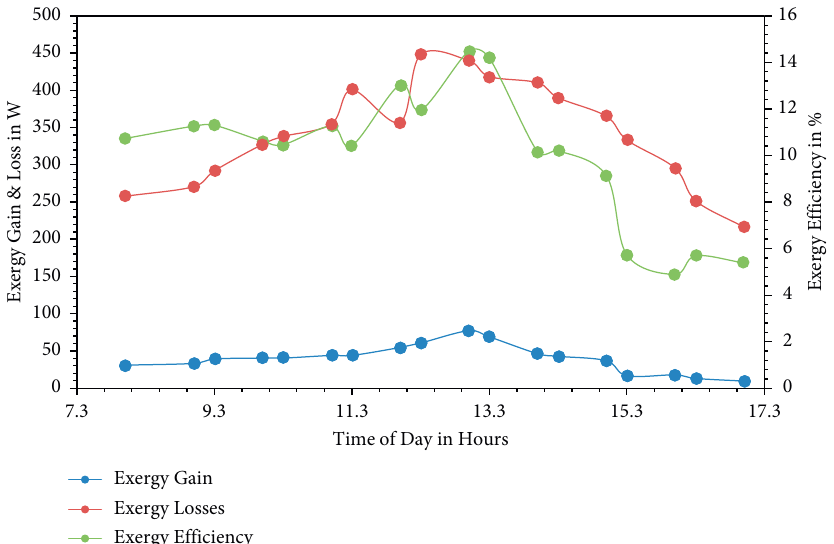
Figure 9: Hourly variations of energy gain, energy loss, and energy efciency of the SAH with inverted bafe plate.